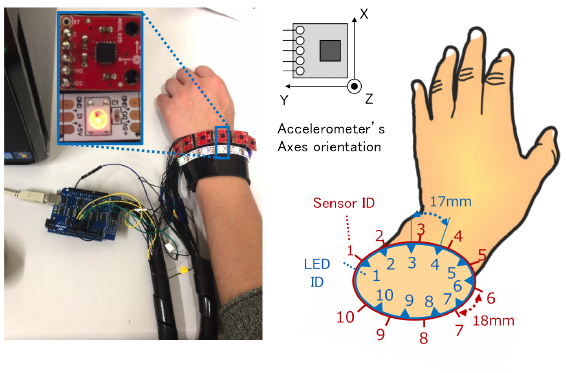
Figure 2. Equipment of the prototype system and the assignment of the IDs of sensors and